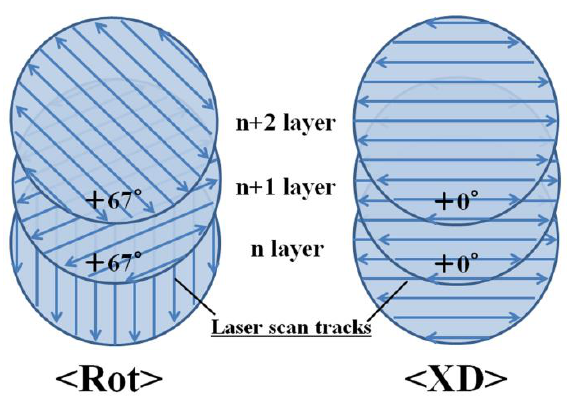
Figure 1. Schematic illustrations of laser scanning patterns. ( a ) rotation pattern (Rot), ( b ) unidirectional pattern of x -direction (XD).